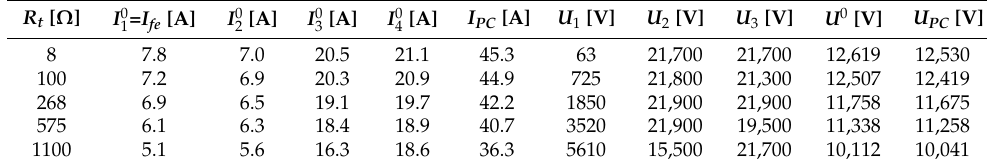
Table 11. The values effective of currents and voltages during the single-phase-to-ground